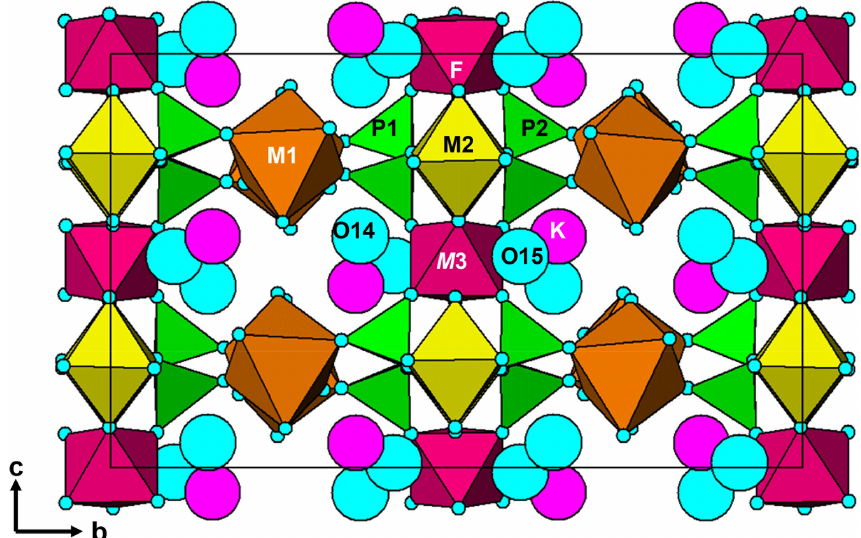
Figure 6. [100] projection of the structure of pleysteinite, made using ATOMS (Dowty, 2006).